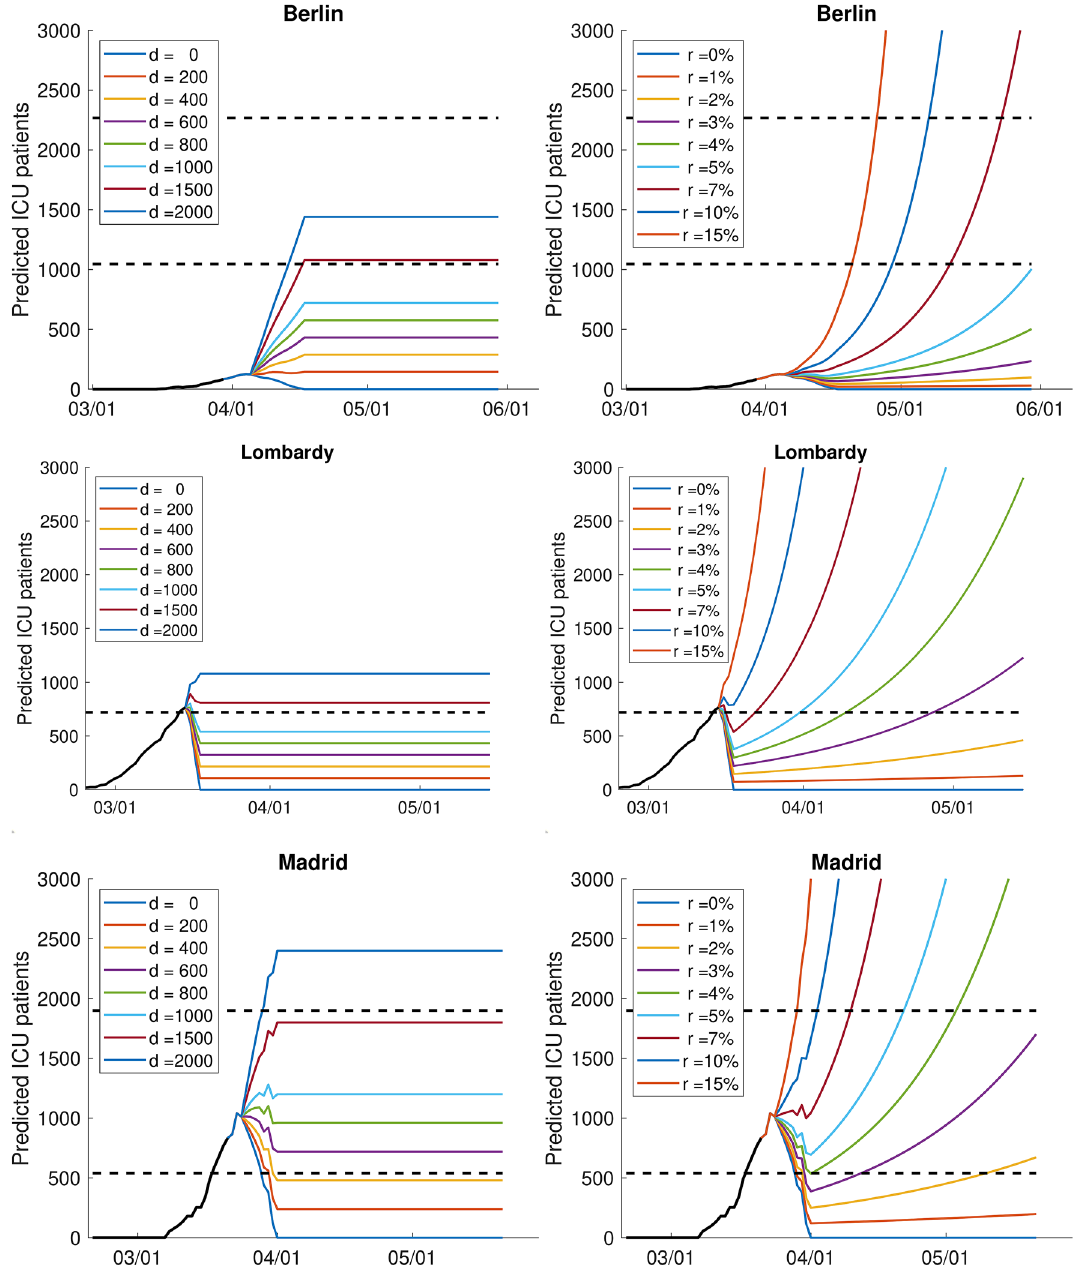
Figure 3. Predicted number of ICU patients assuming different linear (left) and exponential growth (right), separately for Berlin, Lombardy and Madrid. The black line corresponds to the true observations until seven days after the lockdown. The dashed black line indicates the estimates of